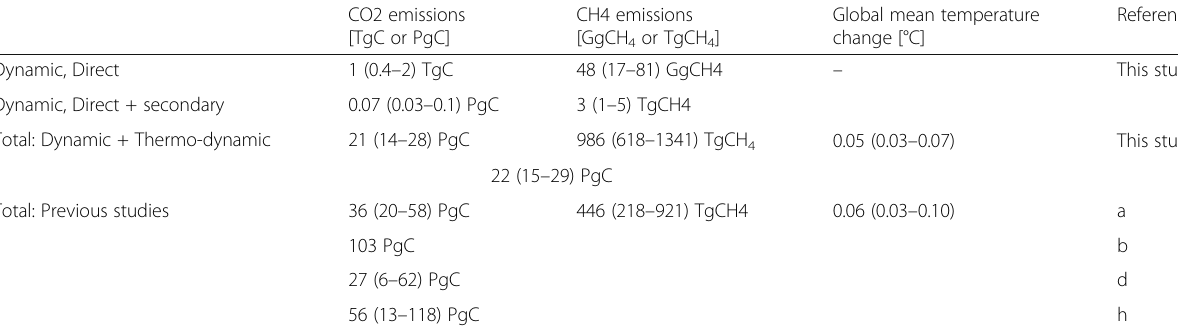
Table 4 Same as Table 3, but for the RCP2.6 scenario